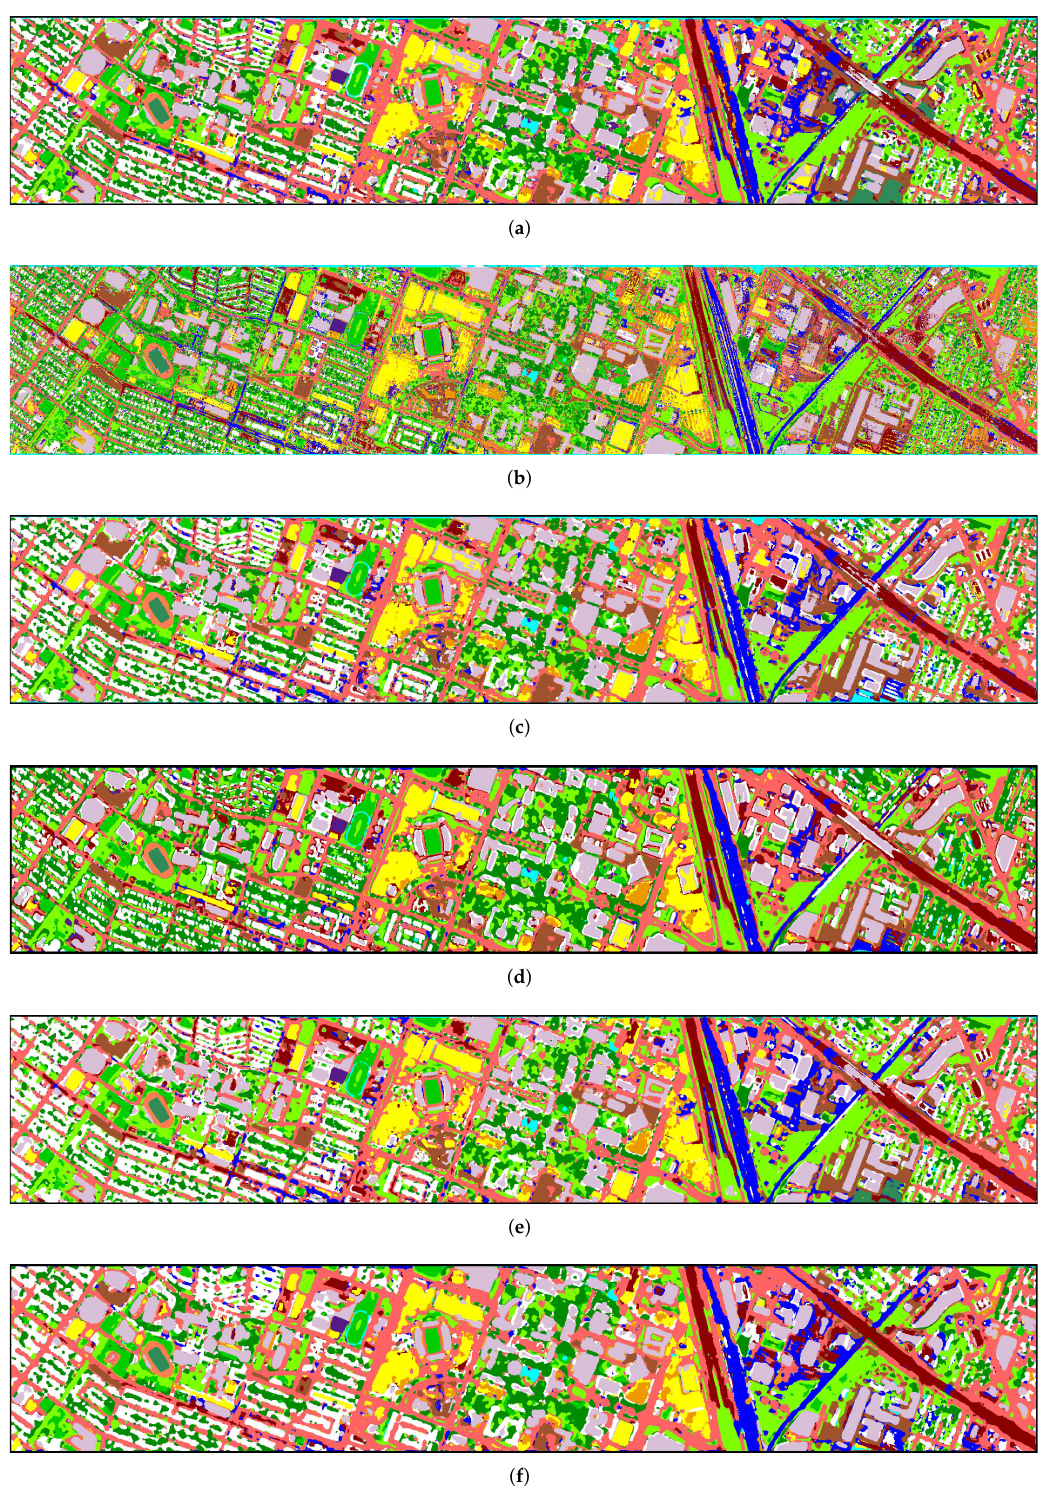
Figure 9. Classification maps of the 2012 Houston data using different models. ( a ) Two-branch. ( b ) EndNet. ( c ) MDL-Middle. ( d ) FusAtNet. ( e ) S 2 ENet. ( f ) PC 2